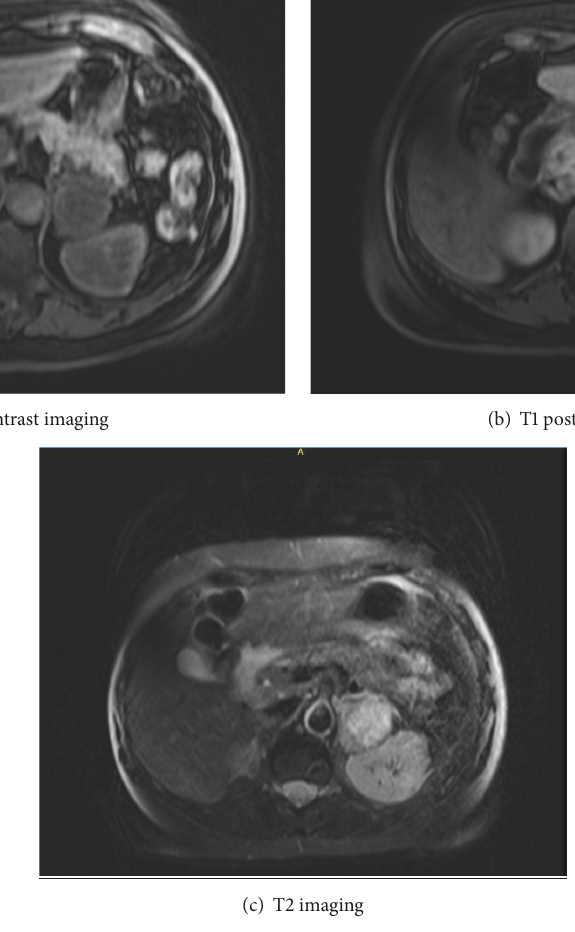
Figure 1: MRI abdomen with and without contrast. A 3.4 x 4.0 x 4.7 cm mass is seen in the left adrenal gland. The lesion demonstrated heterogeneous T2 hyperintense/T1 isointense to muscle signal. The T1 signal of the lesion was hypointense relative to the contralateral right adrenal